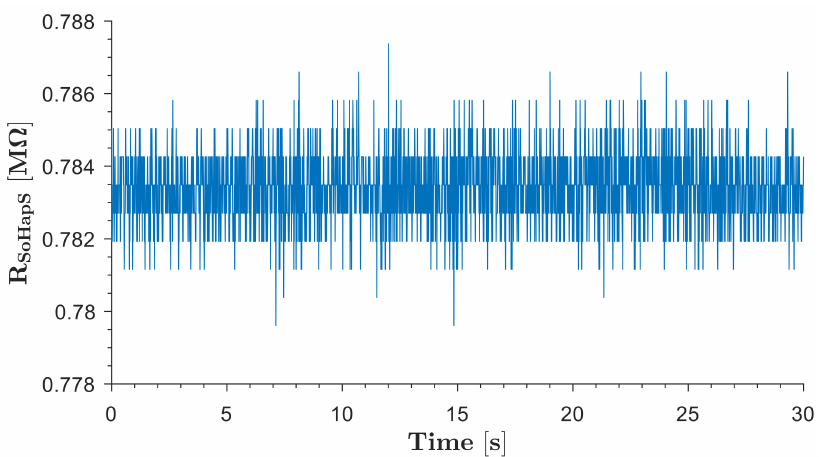
Figure 7. Electrical resistance of soft force sensor of SoHapS when no load was applied and at a 100 Hz sampling